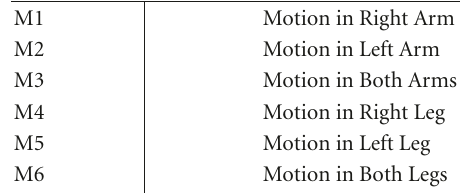
Table 1: Behavioral classes for selected articulated